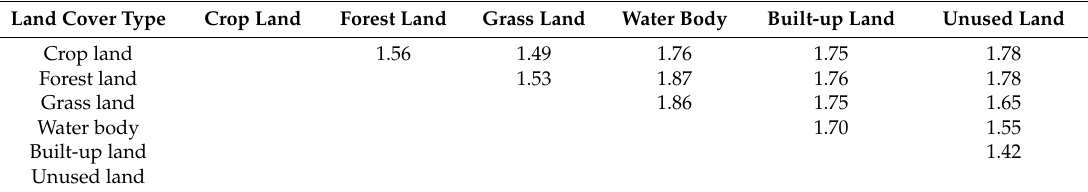
Figure 3. EVI curves of different land cover types before and after HANTS processing: ( a ) original EVI curves; ( b ) HANTS-corrected EVI curves. Table 1. J-M distance between different land cover types before HANTS processing.